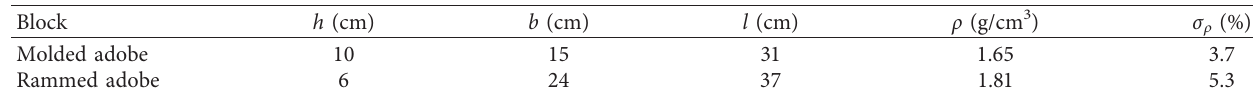
Figure 2: Manufacturing process. (a) Molded adobe. (b) Rammed adobe. Table 2: Dimensions and densities of the earth